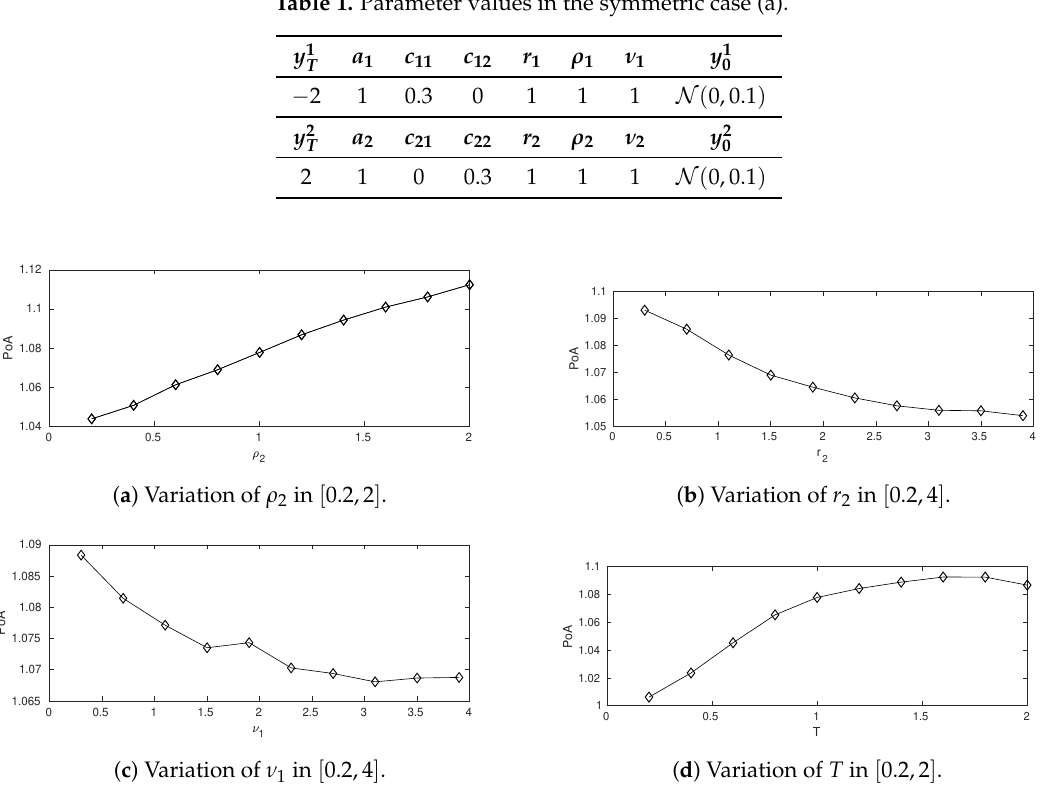
Table 1. Parameter values in the symmetric case (a).